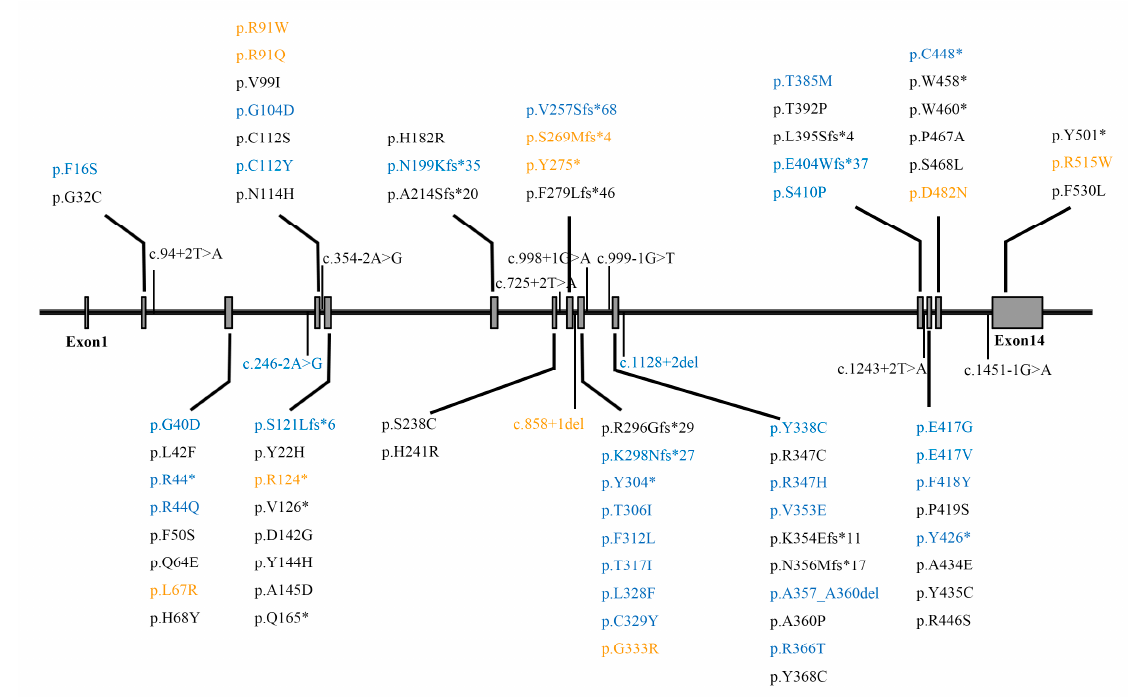
Figure 1. The distribution of 85 distinct variants of RPE65 identified in a Chinese cohort including 78 unrelated families. Blue: variants only identified in 29 families of our own cohort. Black: variants reported in pedigrees from eight previously published papers. Yellow: variants identified or reported in both our own cohort and the eight previously published papers; * a stop codon (http://varnomen.hgvs.org/recommendations/protein/variant/substitution/).